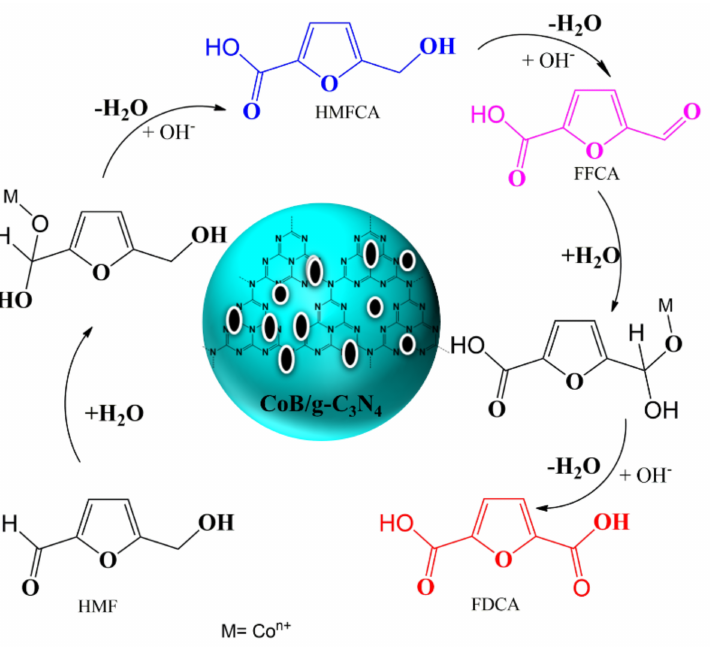
Figure 6. Proposed mechanism of the electrochemical HMF oxidation to FDCA over a CoB/g-C 3 N 4